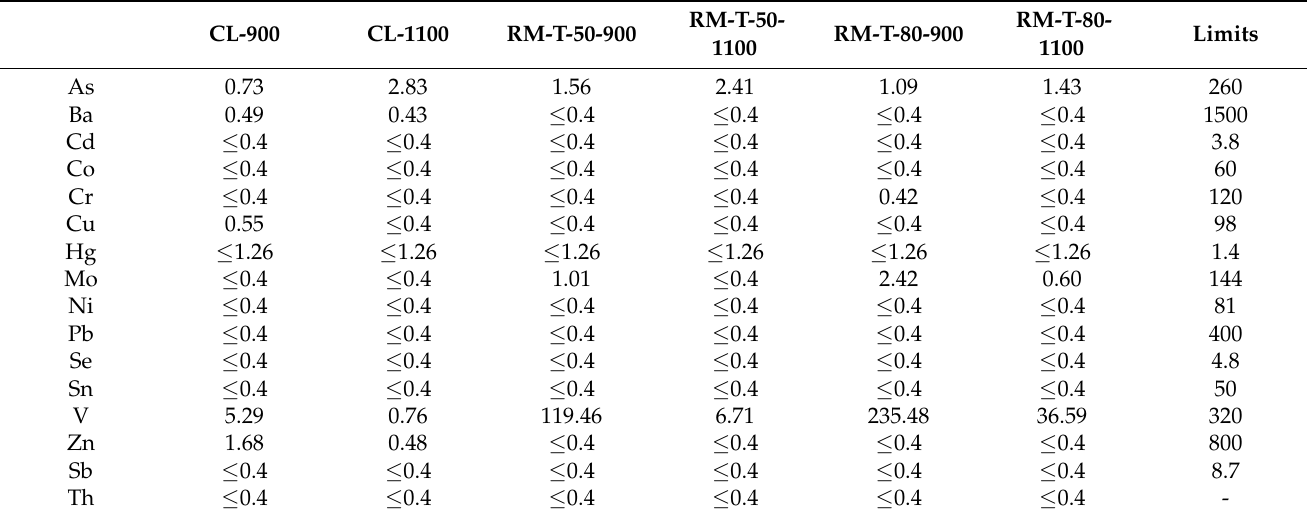
Table 7. Leaching of bricks according to NEN-7375 (mg/m 2 ).